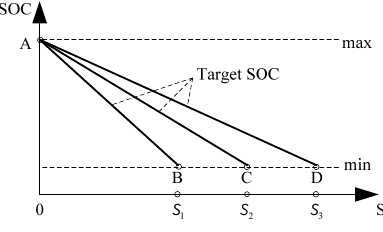
Figure 3. Battery target SOC for different target driving